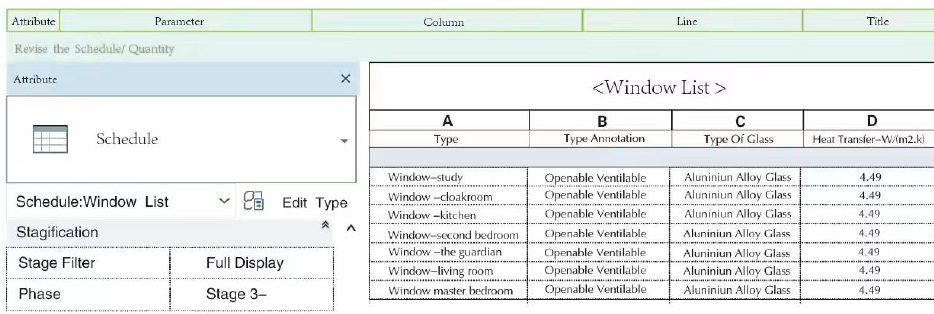
Figure 9. Analysis results of heat transfer coefficient of the exterior window of a decoration project in Xuzhou.